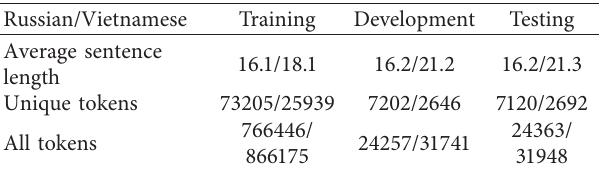
Table 4: Statistical summary of the datasets.